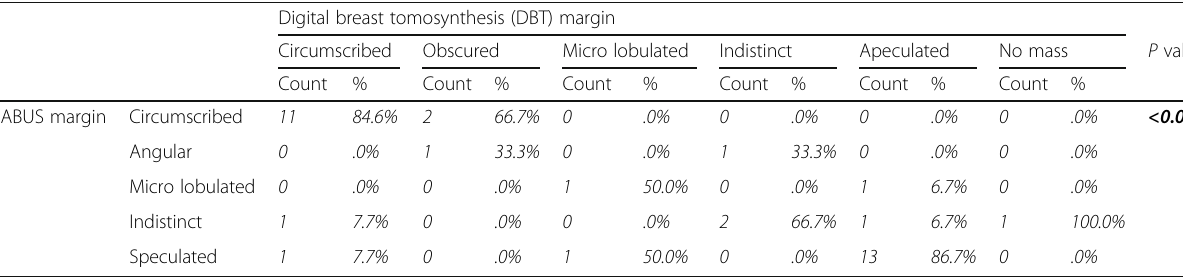
Table 3 Relation between both modalities regarding the margins Digital breast tomosynthesis (DBT) margin